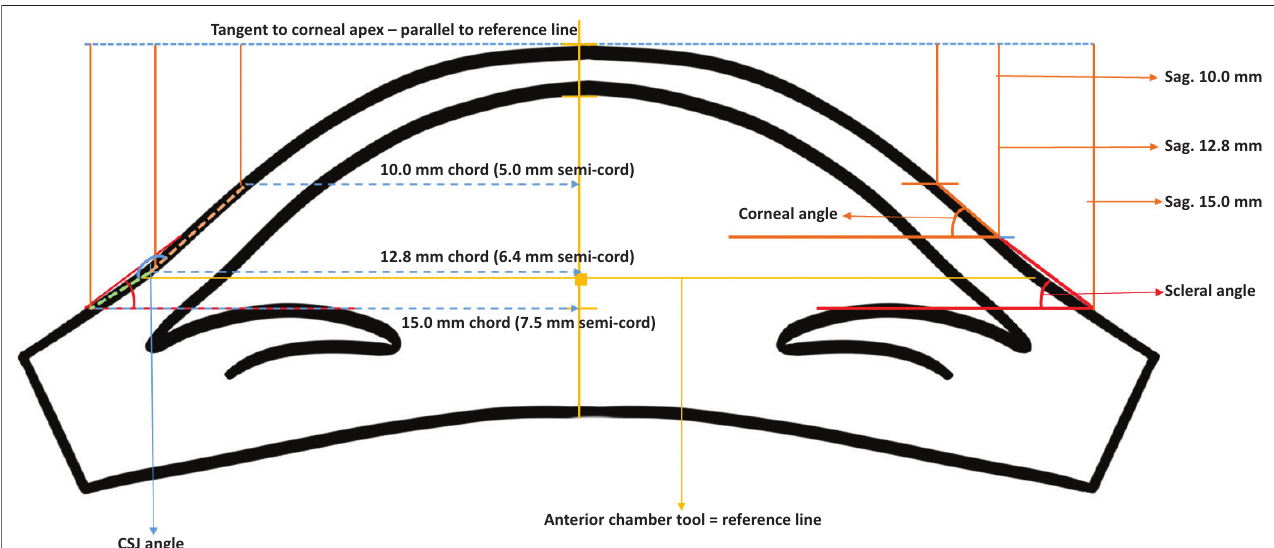
FIGURE 1: Sagittal height and corneoscleral angle